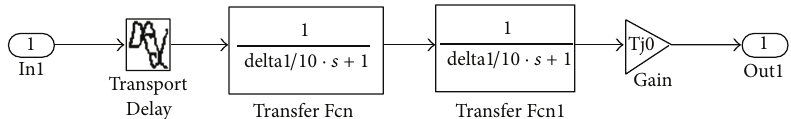
Figure 4: The thruster model in Simulink.